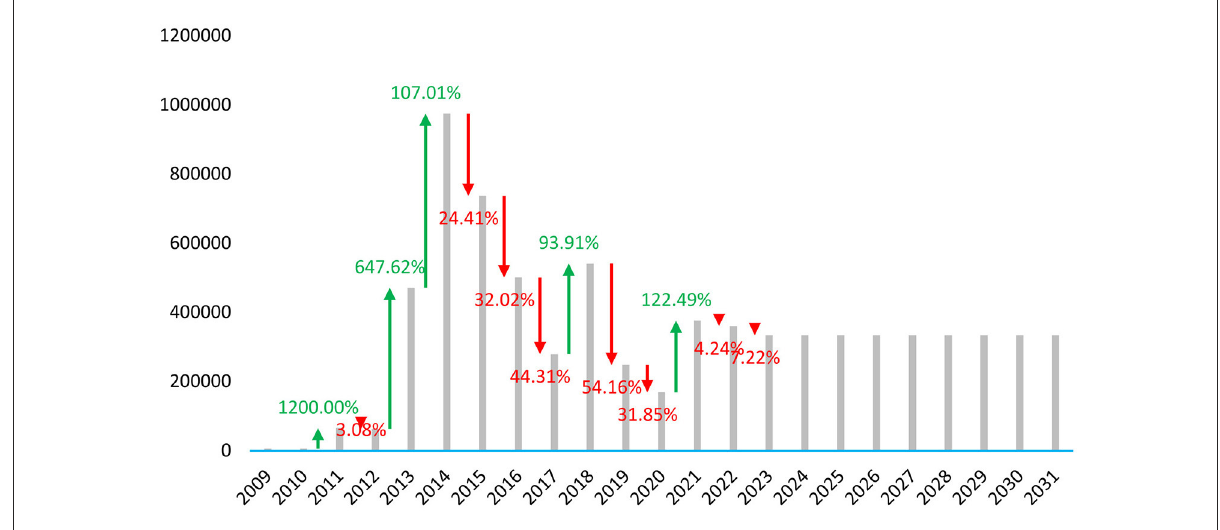
FIGURE2 Percentage change in annual figures of internally displaced persons in Nigeria due to conflict and violence from 2009 to 2031.